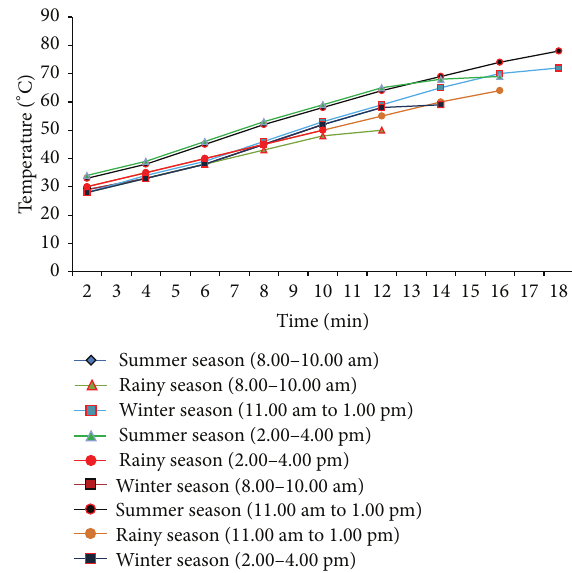
Figure 4: Comparison of temperature profile by using DC